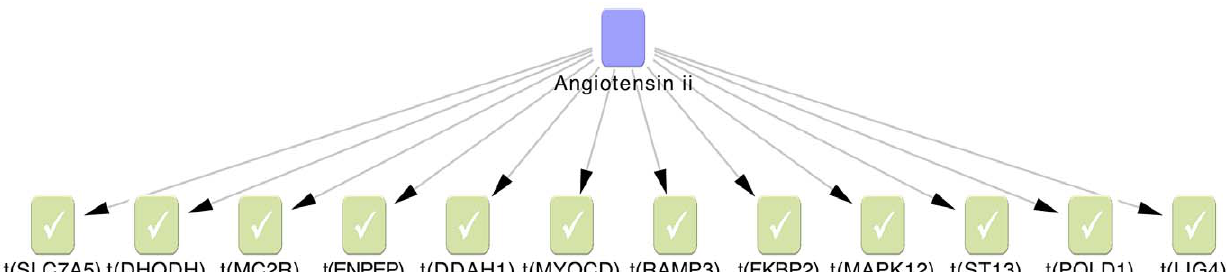
Figure 3. The Angiotensin II regulatory network was identified by causal reasoning from 138 genes associated with pain sensitivity. Causal reasoning uses directed molecular interactions to work upstream from the genes in this study (green) to identify regulators such as angiotensin II (blue) that have a causally correct regulatory role for a significant number of input genes. Correctness is determined by giving each input gene a direction of effect. Here, we presumed a loss of function (e.g. down regulation in activity) to all of our genes. Angiotensin II has direct causal connections to 12 of the genes from our 138, which can be increased to 30 if one intermediary node is allowed in the network (Figure S1). Distribution of novel rare variants identified according to minor allele frequency in a) TUK1 and b) TUK2 datasets.